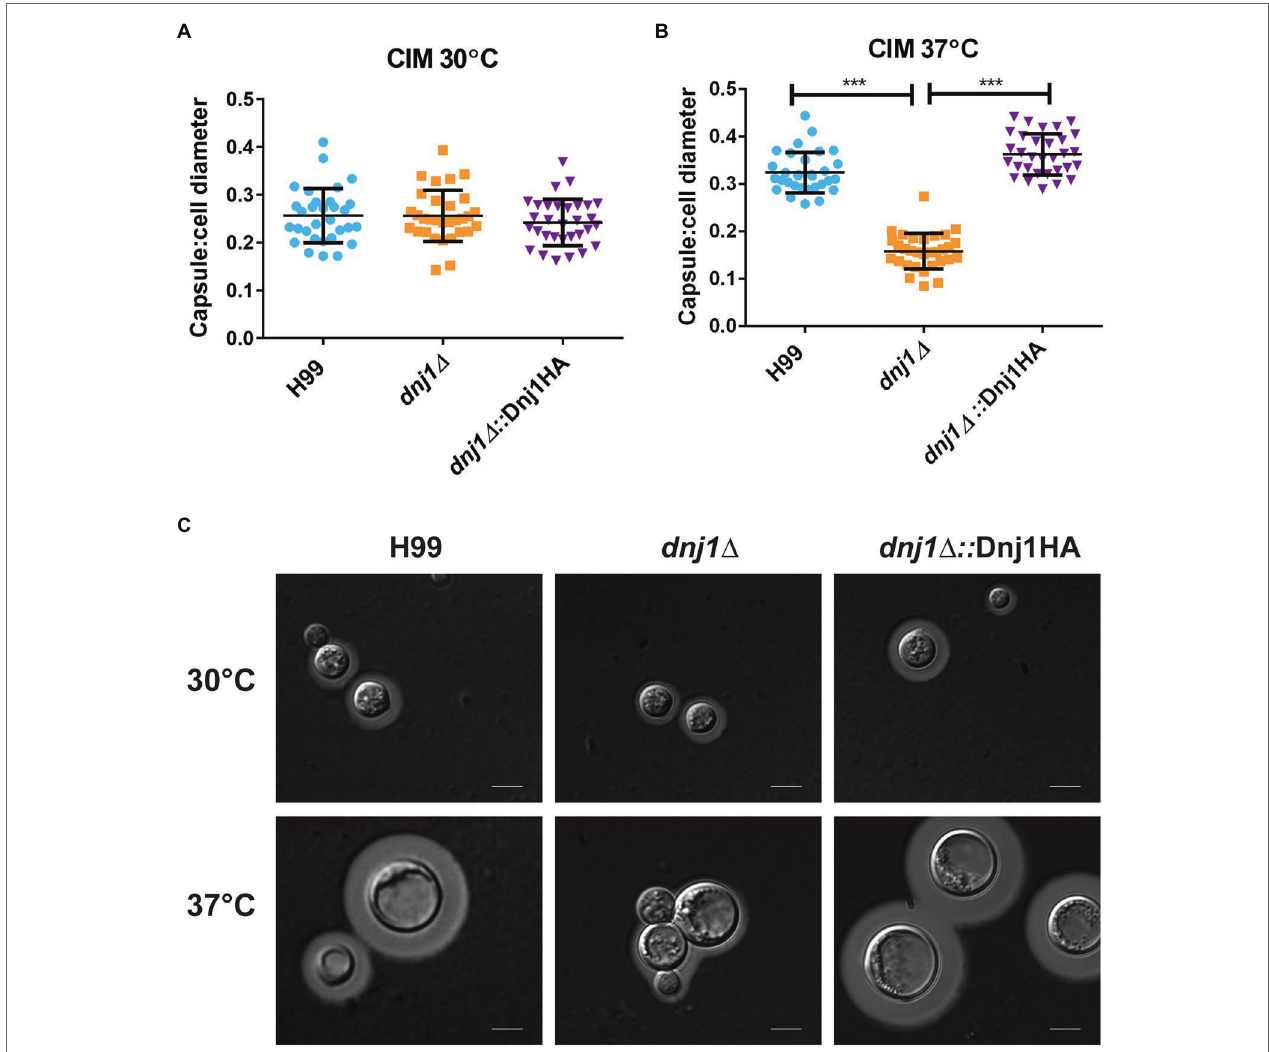
FIGURE 6 | Dnj1 is required for capsule synthesis at human body temperature. Capsule synthesis was induced in low iron capsule inducing media (CIM) at 30 and 37 ° C for 48 h. (A,B) The capsule width and cell diameters of 30 cells each from the wild type (H99), deletion mutant ( dnj1 ∆ ), and complement ( dnj1 ∆ ::Dnj1HA) strains were measured. The ratio of capsule thickness to cell diameter for each cell measured is shown as an individual dot. The mean and SD are shown for each group. Statistical significance was determined using a one way ANOVA with Tukey’s multiple comparison tests (*** p < 0.005). (C) Representative images are shown of capsule stained with India ink for each strain at the indicated temperatures. Scale bar = 5 μ